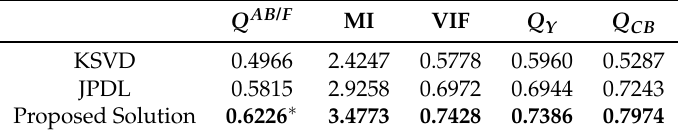
Table 1. Fusion Performance Comparison - 1 of Multi-focus Fluorescence Image Pairs.